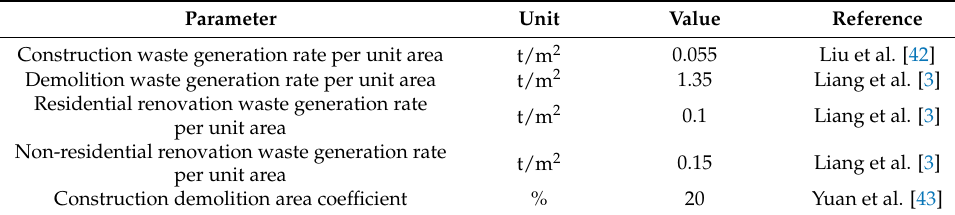
Table 1. Parameters for construction waste generation estimates.